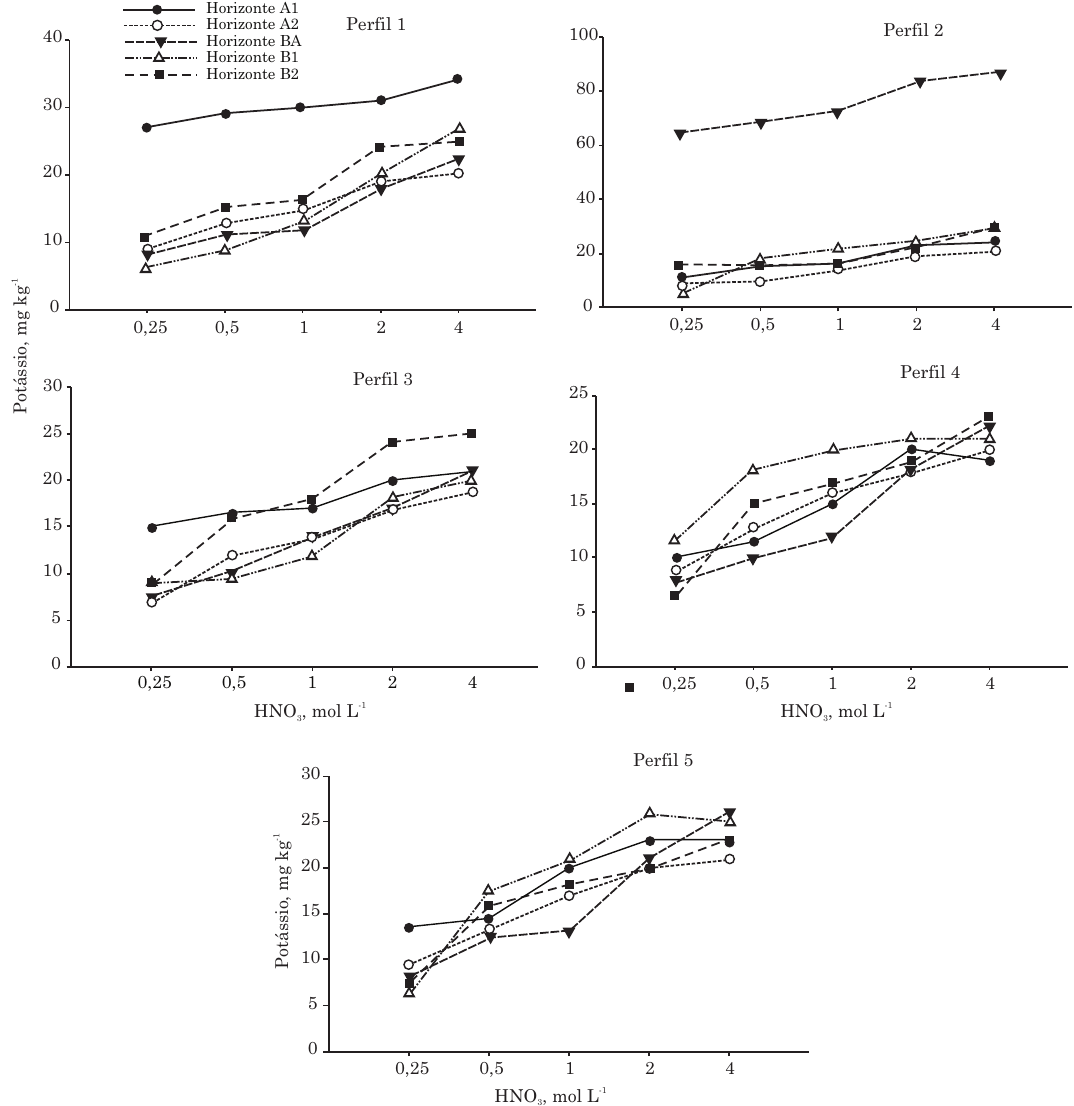
Figura 3. Teores de K nos horizontes A1, A2, BA, B1, B2 dos perfis de solos extraídos com diferentes concentrações de HNO 3 fervente: 0,25; 0,5; 1,0; 2,0; e 4,0 mol L -1